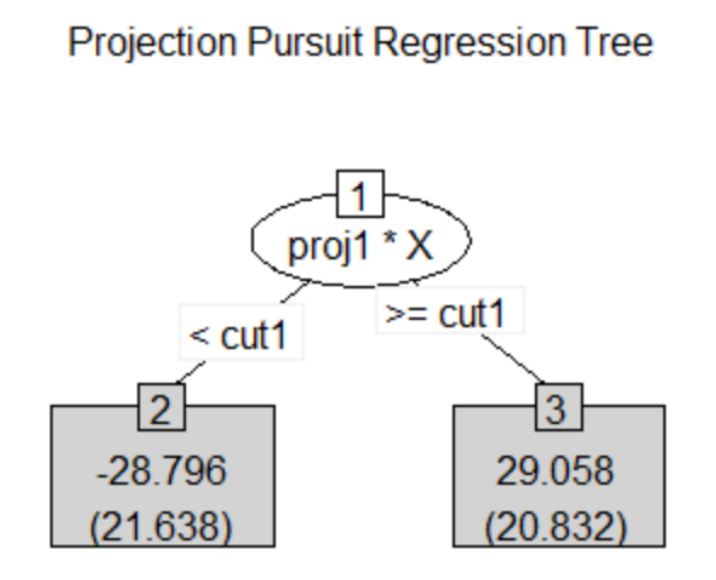
Figure 3. Simple projection pursuit regression tree for the toy example with depth